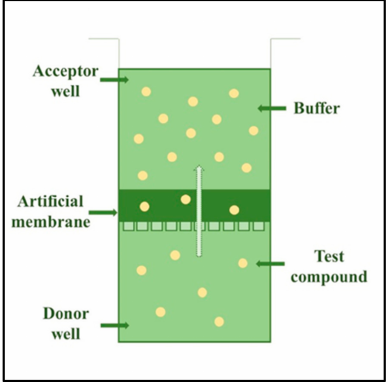
Figure 1. The structure of one-well of a 96-well plate of a parallel artificial membrane permeability assay (PAMPA) system.